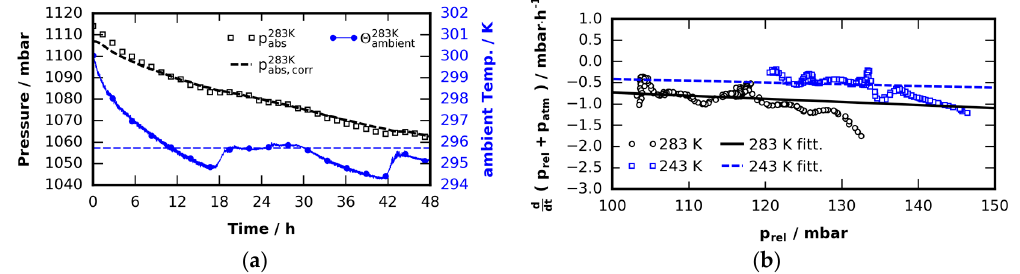
Figure 11. Long-term pressure decay analysis: ( a ) the influence of temperature fluctuations of the ambient temperature (blue line with dot markers) becomes visible in the pressure signal (square markers). A correction (discussed in the text) of this effect is possible (dashed black line); and ( b ) the sum of gauge and atmospheric pressure change rate, obtained from pressure tests using an empty cell at different temperatures are shown. The linear fit functions to the data directly yield the loss rate.